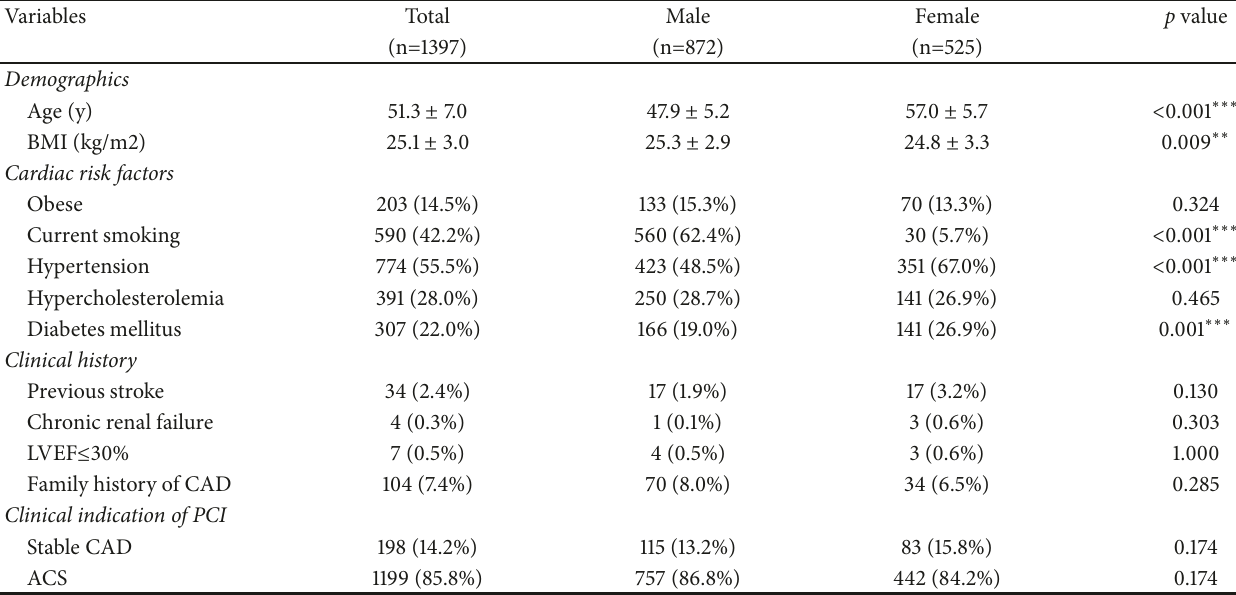
Table 1: Baseline characteristics: male versus